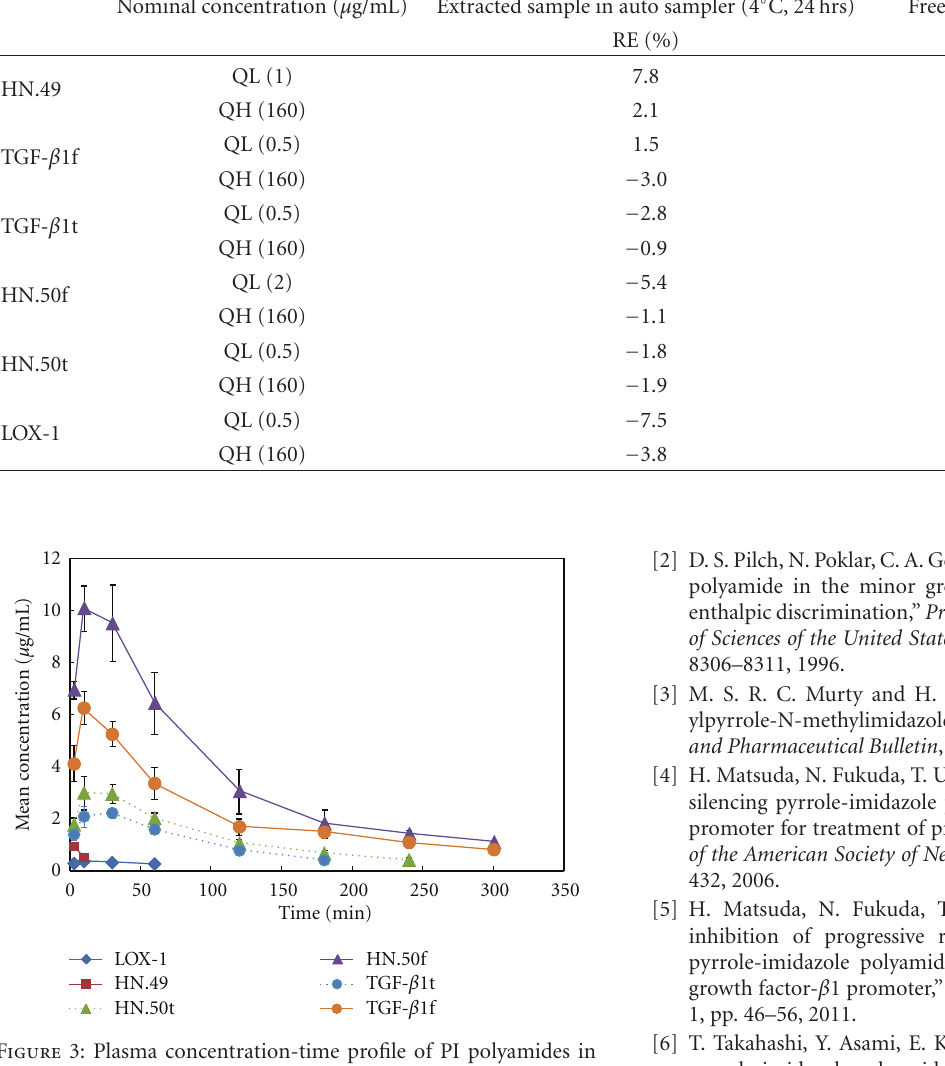
Figure 3: Plasma concentration-time profile of PI polyamides in rats after administration. Each data point represents the mean ± SD of three to four